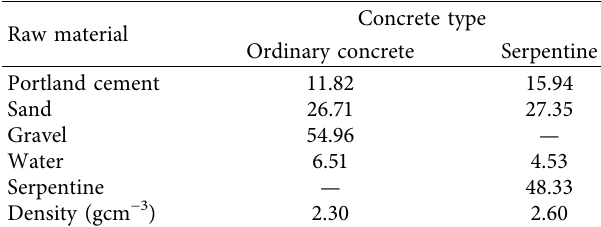
Table 1: Percentage composition of ordinary concrete and serpentine.